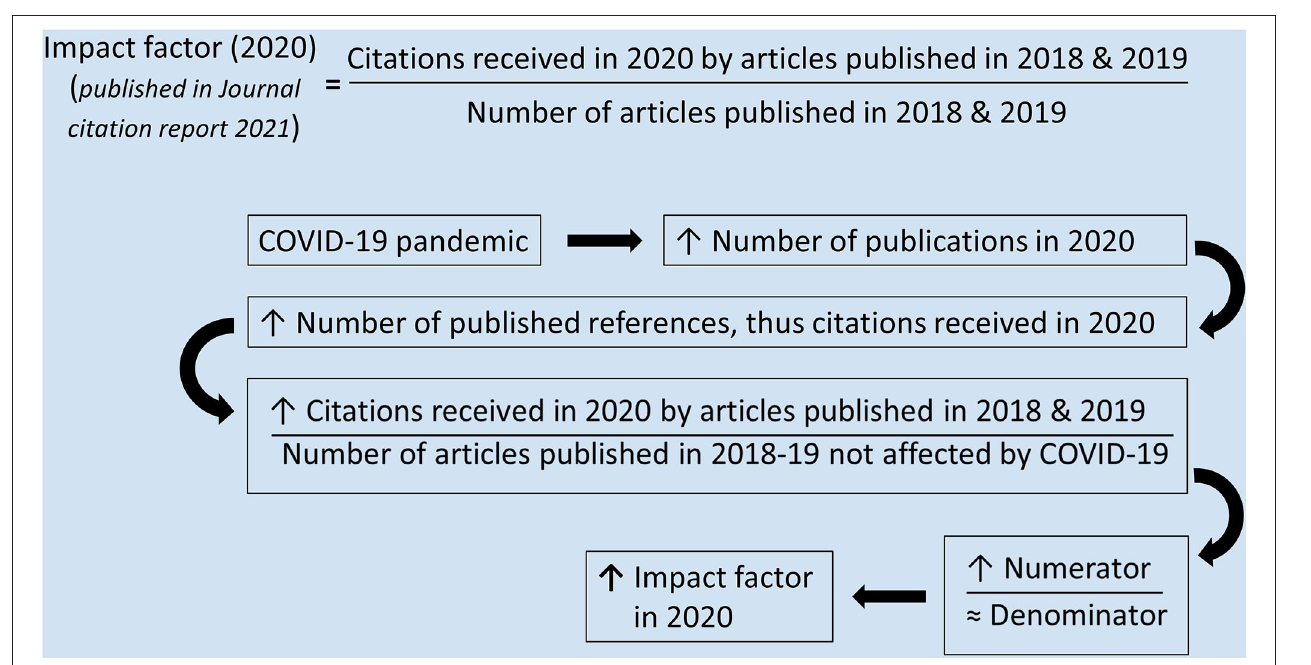
than subscription journals with every passing year ( Table 3 ). In 2020, the rate of acceleration for